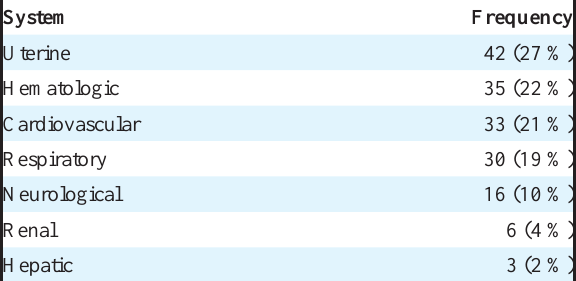
Table 4. Organ dysfunction/life threatening conditions (n=157, > 1condition in 5%).